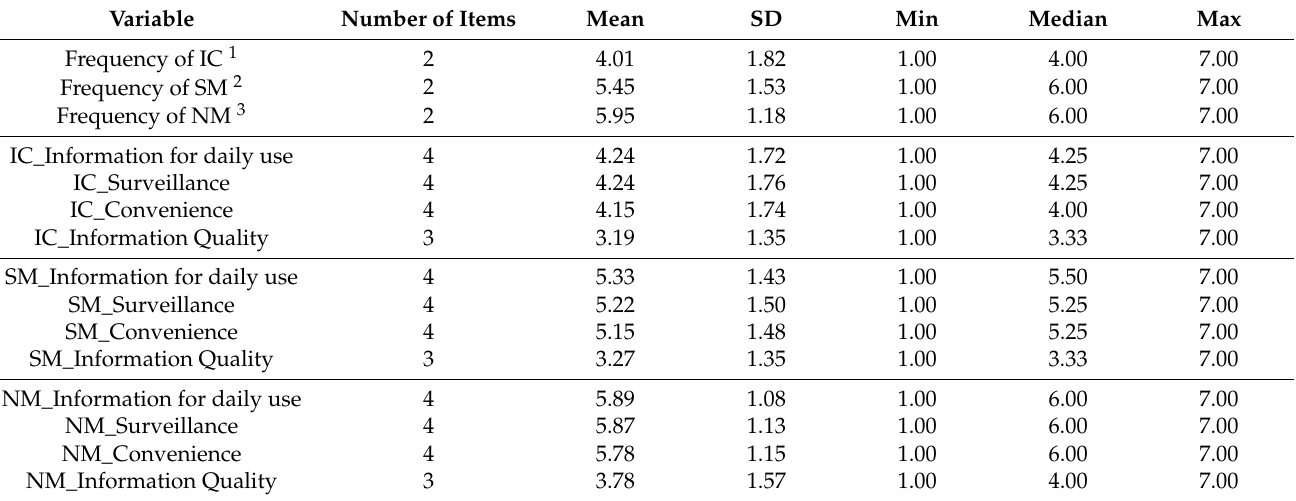
Table 2. General statistics for major variables.